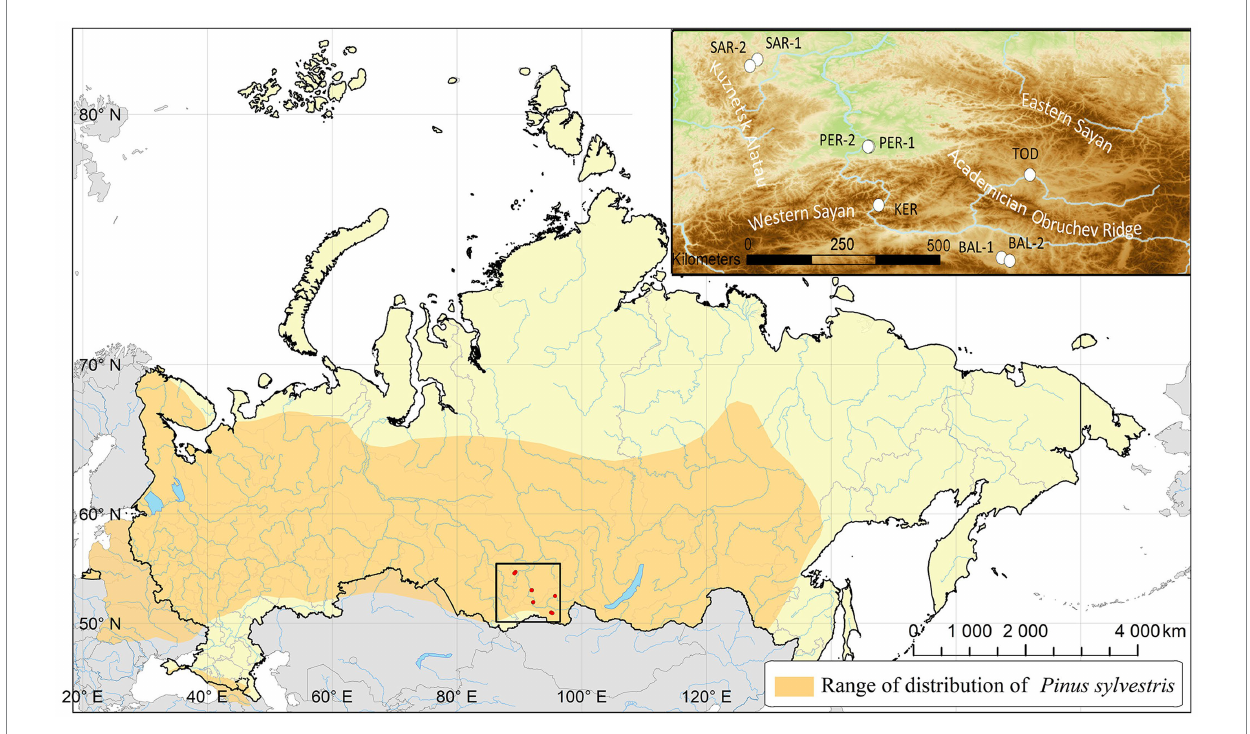
FIGURE 1 Location of the studied Scots pine populations in southern Middle